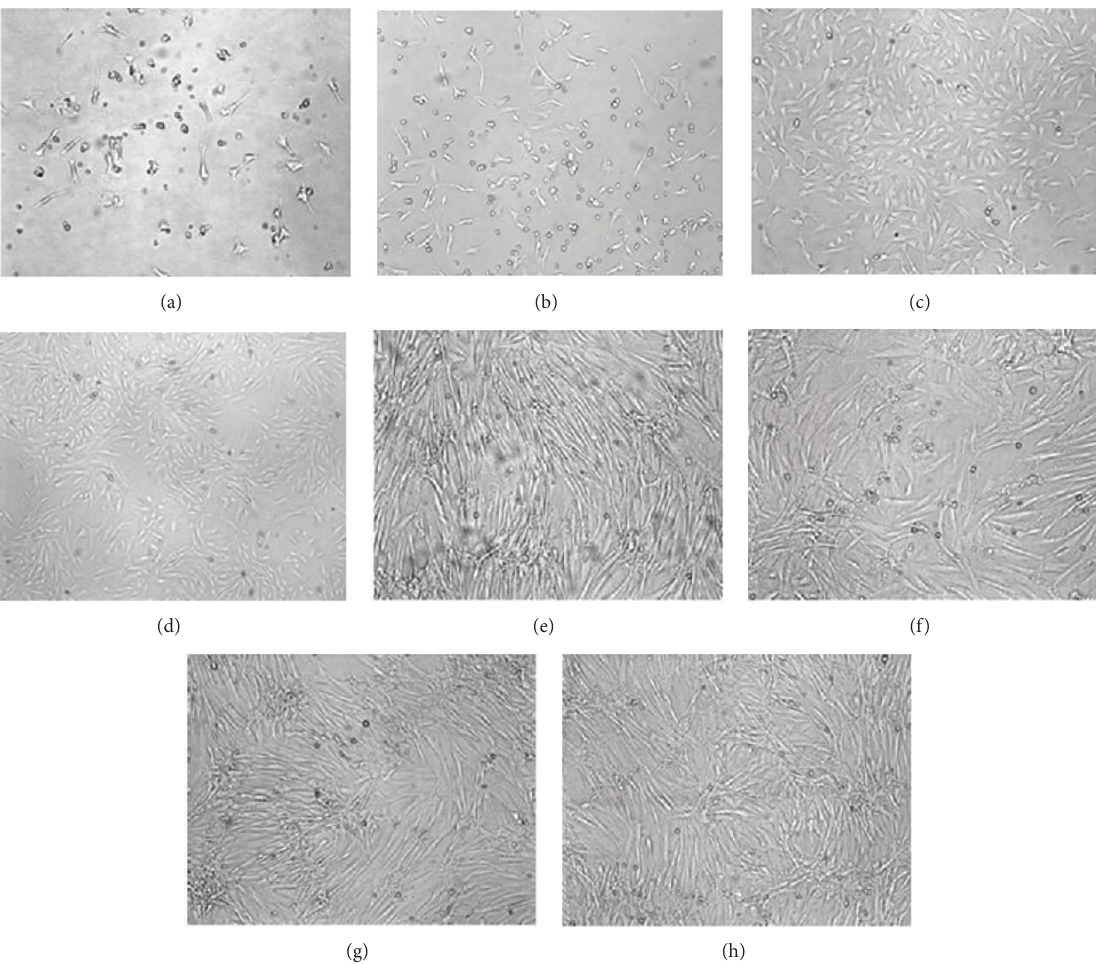
Figure 1: Cellular characterization. (a) Primary culture 24 h; (b) primary culture 3 d; (c) primary culture 9 d; (d) passage 3; (e) control group; (f) TGF- 𝛽 1 group; (g) 5-AZA group; (h) TGF- 𝛽 1 + 5-AZA